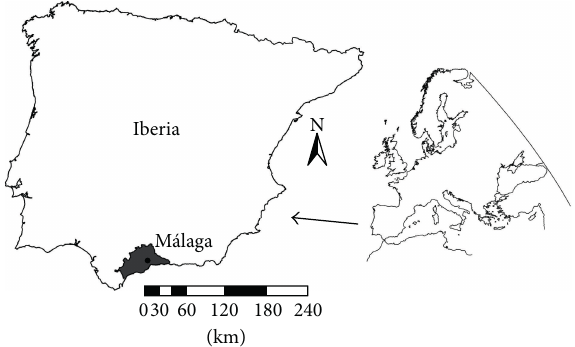
Figure 1: Study area represented in the European context. On the map on the left, grey shadows correspond to M´alaga, within